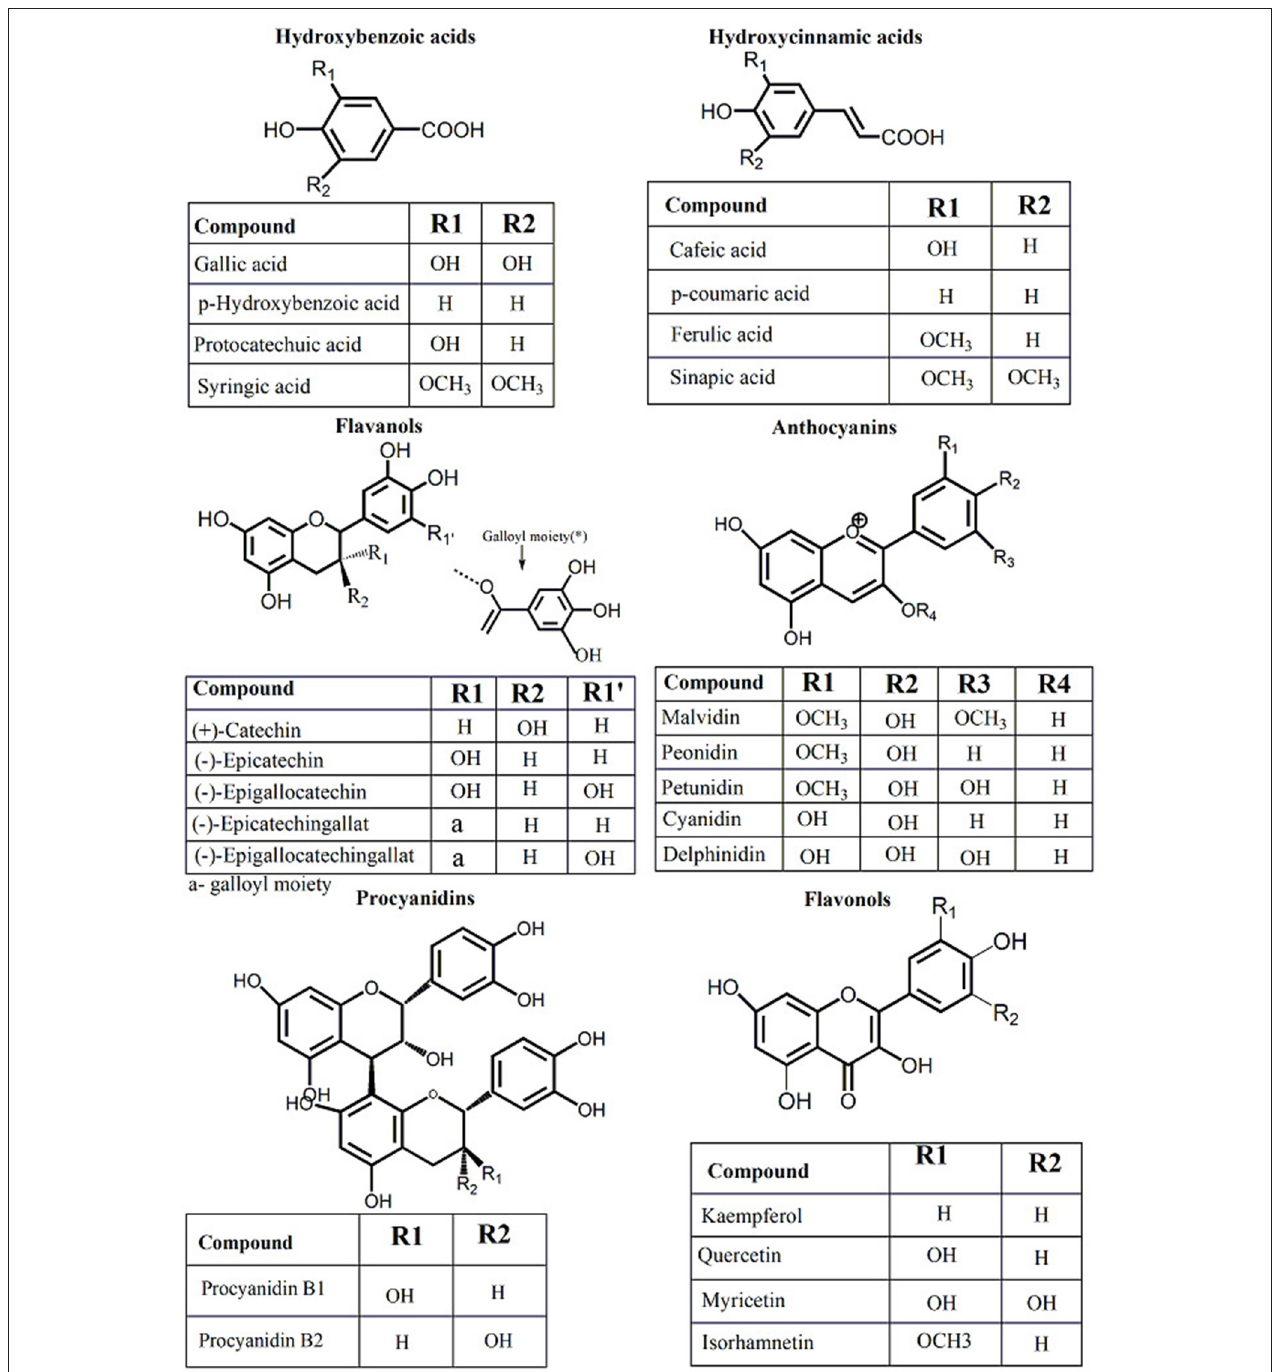
FIGURE 1 | Chemical composition of principal phenolic compounds identified in grapevine and wine by-products..